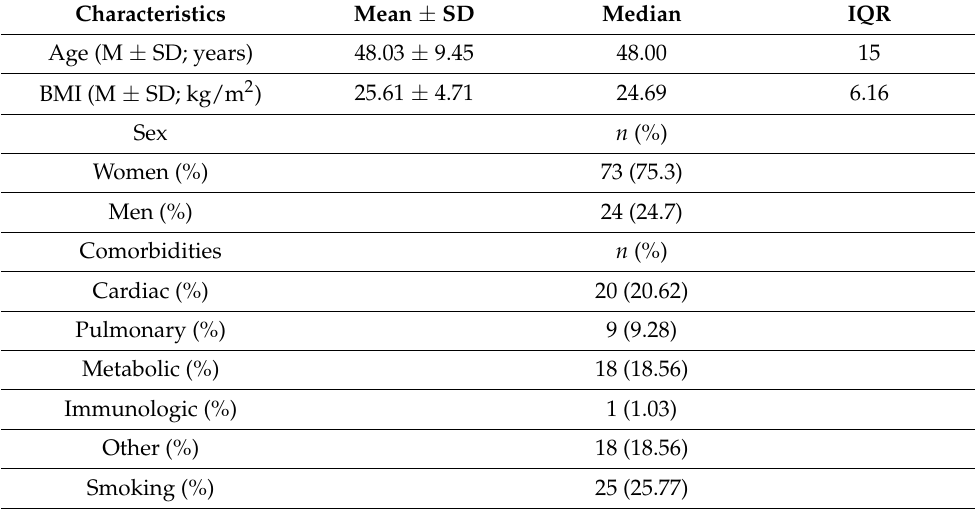
Table 1. Baseline characteristics of the study cohort ( n = 97).